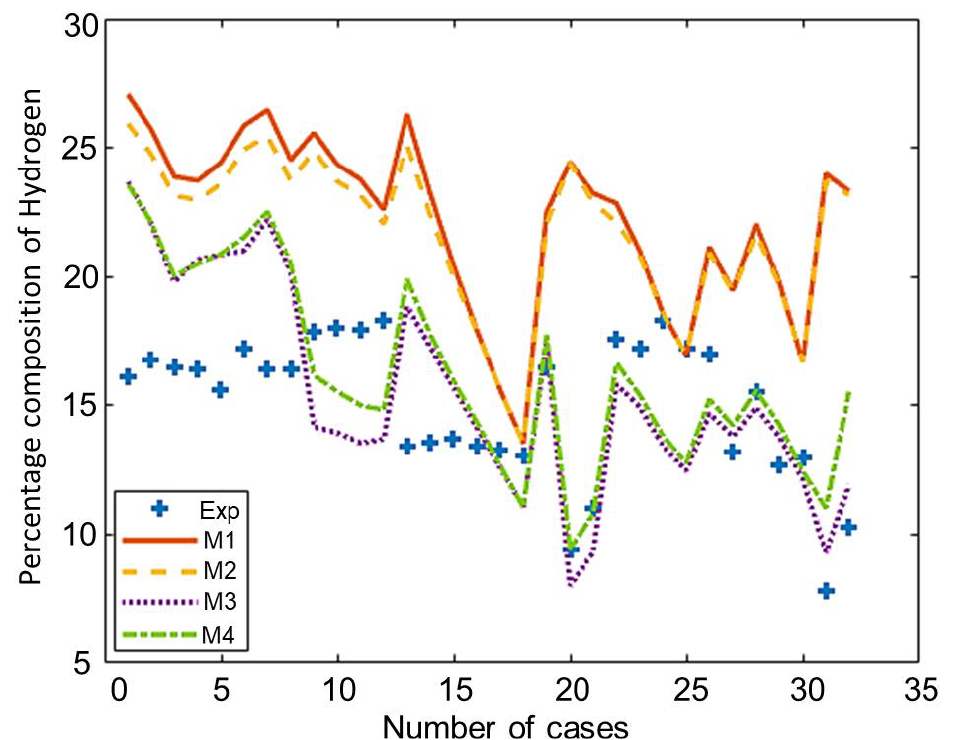
Figure 3. Comparison of hydrogen composition given by experiments and models.